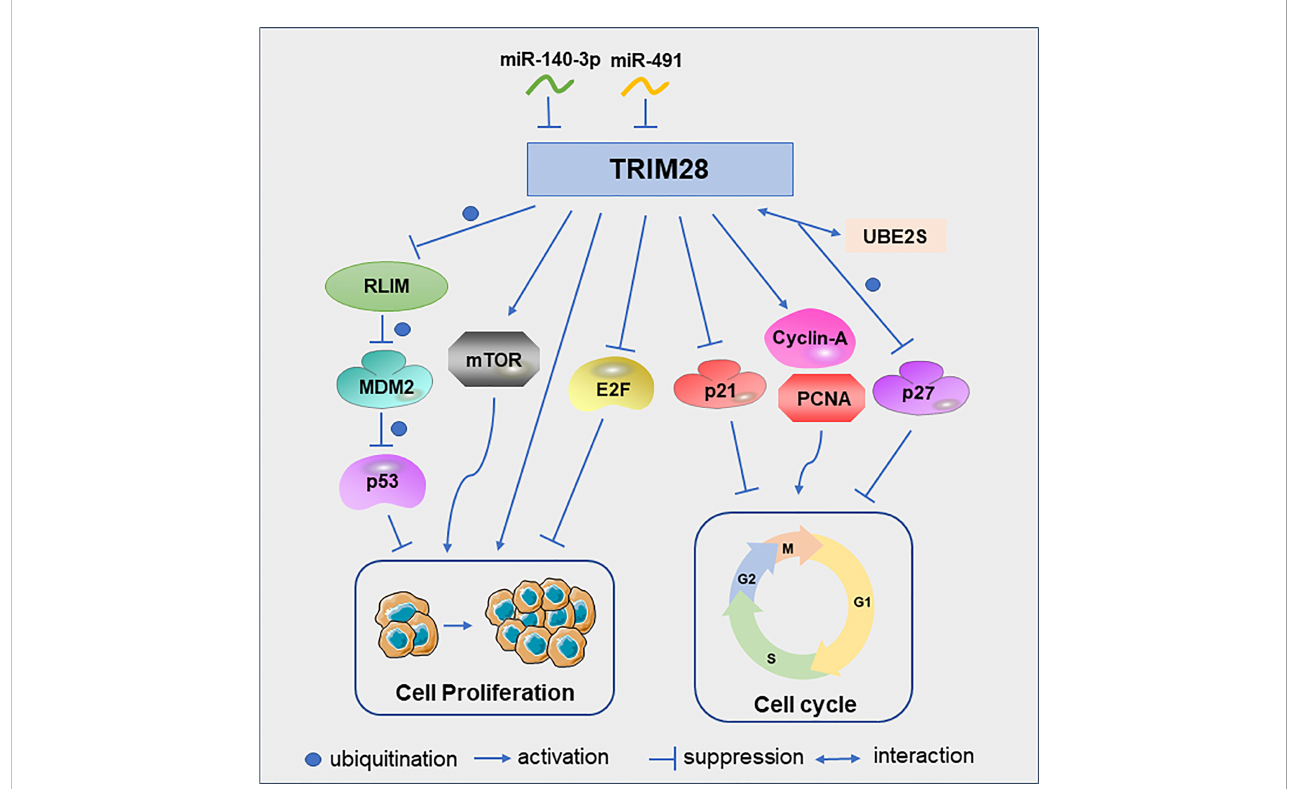
FIGURE 3 TRIM28 participates in the cell cycle and proliferation. Schematic diagram of the TRIM28 signaling pathway and effectors.